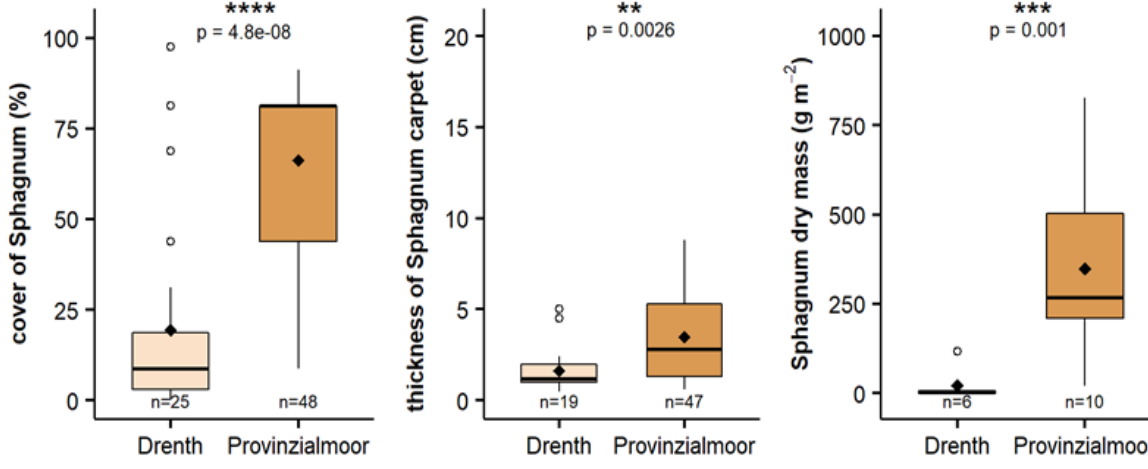
Figure 6. Comparison of the establishment of Sphagnum papillosum on the study sites Drenth and Provinzialmoor in cover (%), carpet thickness (cm) and dry mass (g m -2 ) in September 2018 (including only data from sections where straw was used as protective cover). Carpet thickness includes only measured values where mosses were present. Boxplots are showing median (central thick lines), 25 % and 75 % quartile ranges around the median (box length), outliers (circles) and mean values (rhomb); stars indicate the level of significance; n: number of